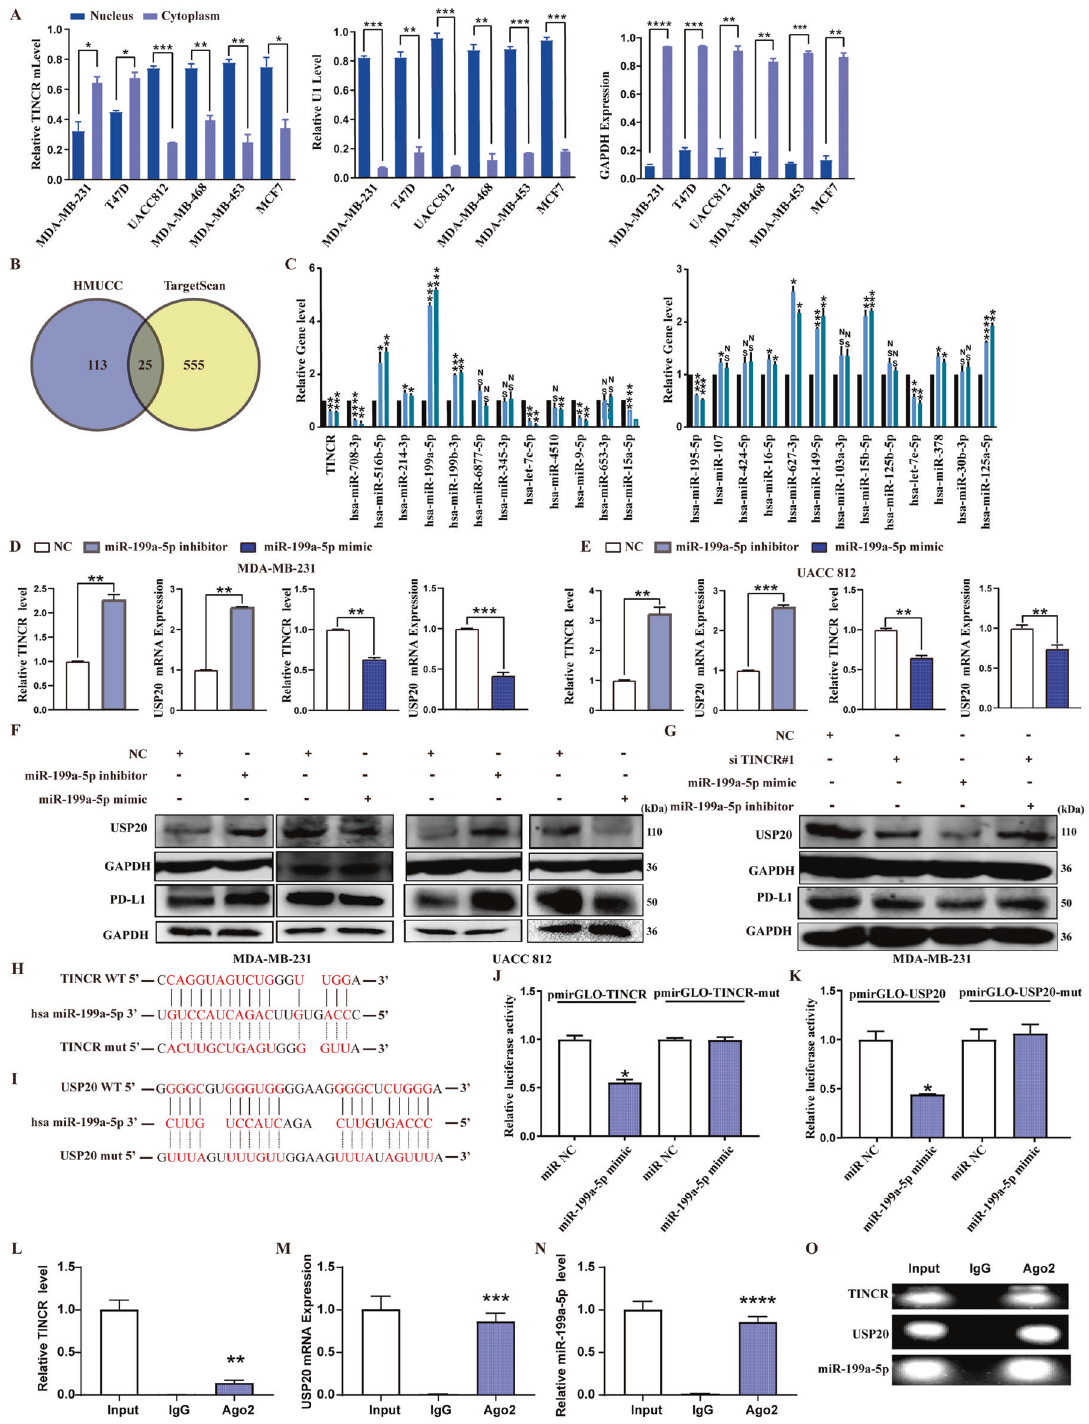
Fig. 4 MiR-199a-5p acts as a molecular sponge to mediate the upregulation of USP20 expression by TINCR. A Subcellular localization of TINCR in breast cancer cell lines assessed by nuclear/cytoplasmic extract isolation assay. B Overlapping miRNAs in transcriptome miRNA sequencing data from the HMUCC cohort and TargetScan. C Expression of miRNAs with TINCR knockdown in UACC812 cells. D – G Expression of TINCR, USP20, and PD-L1. Complementarity between the miR-199a-5p seed sequence and 3 ʹ -UTRs of ( H ) TINCR and ( I ) USP20 by using TargetScan and StarBase online databases. Luciferase-reporter assay assessing the interactions between miR-199a-5p and its binding sites or mutated binding sites in 3 ʹ -UTRs of ( J ) TINCR and ( K ) USP20 in HEK293T cells. L – O RNA immunoprecipitation with a monoclonal anti-Ago2 antibody was used to assess endogenous Ago2 binding to RNA; IgG was used as the control. The levels of TINCR, DNMT1, and miR-199a-5p were determined by qRT-PCR and presented as fold enrichment in Ago2 relative to input. Data are presented as means from three independent experiments ± S.D. * P < 0.05, ** P < 0.01, *** P < 0.001, **** P < 0.0001.